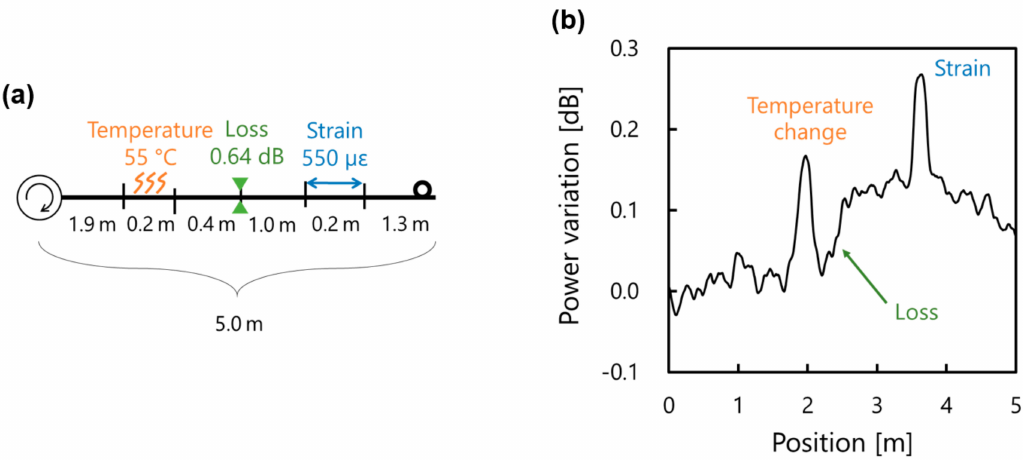
Figure 8. ( a ) Structure of the FUT. ( b ) Measured P B0 change distribution. Reproduced with permission from [59]. Copyright (2016)